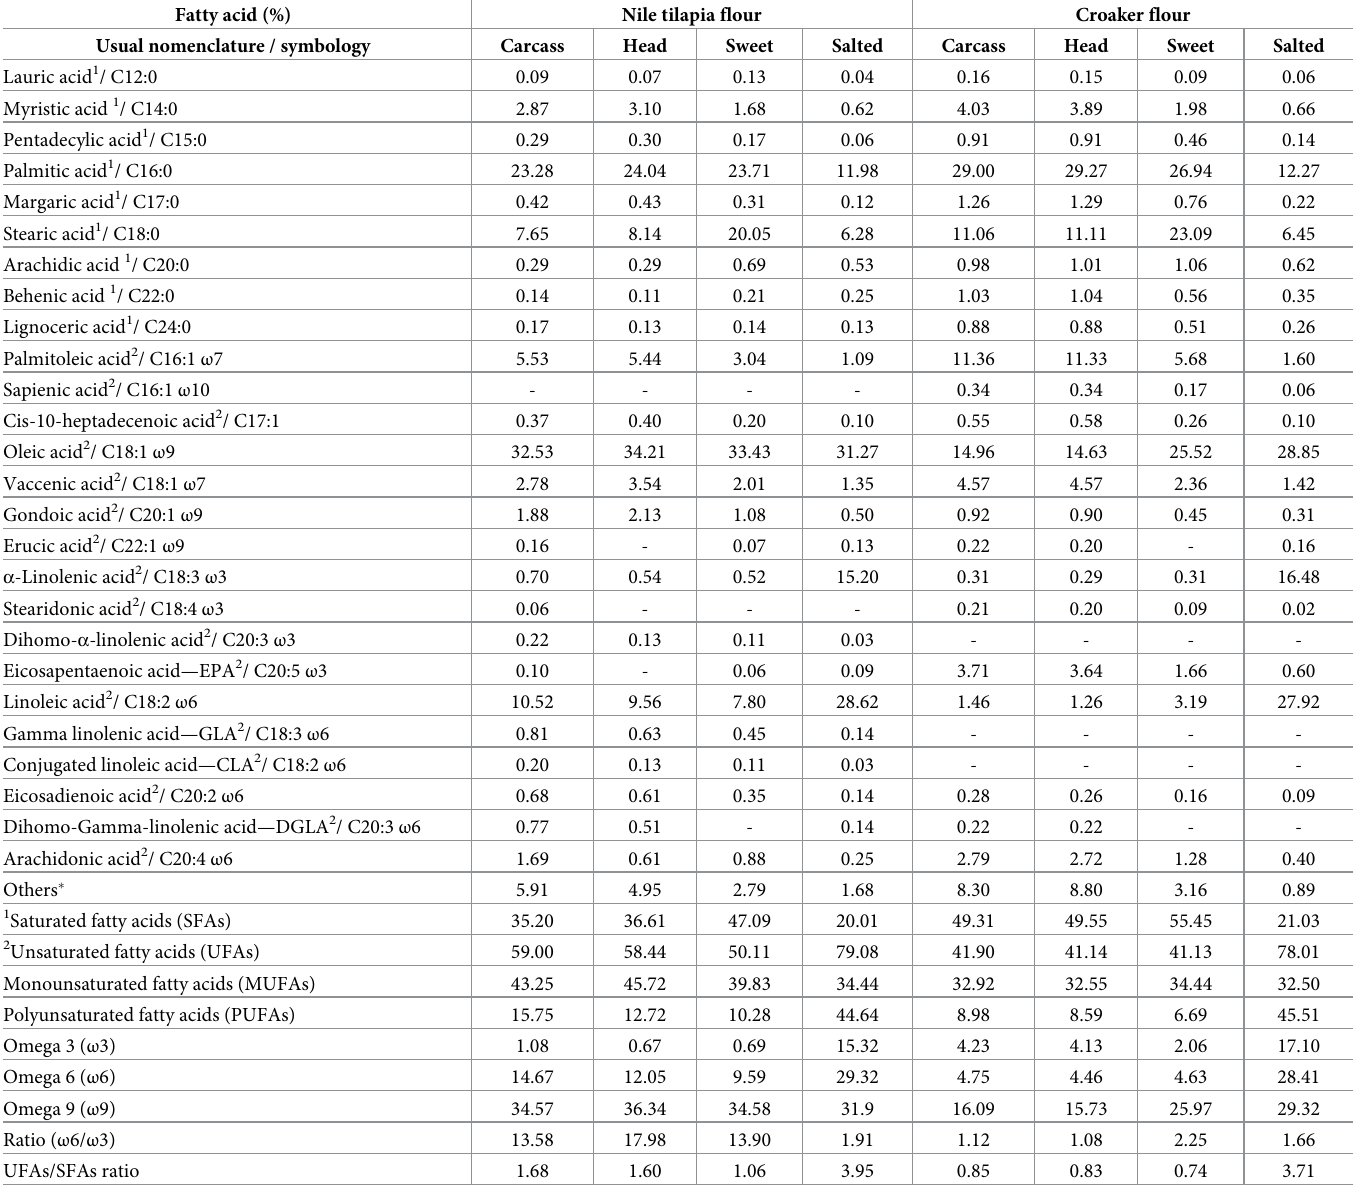
Table 6. Fatty acid profile of flours made from Nile tilapia and croaker carcass, without and with added flavor. Fatty acid